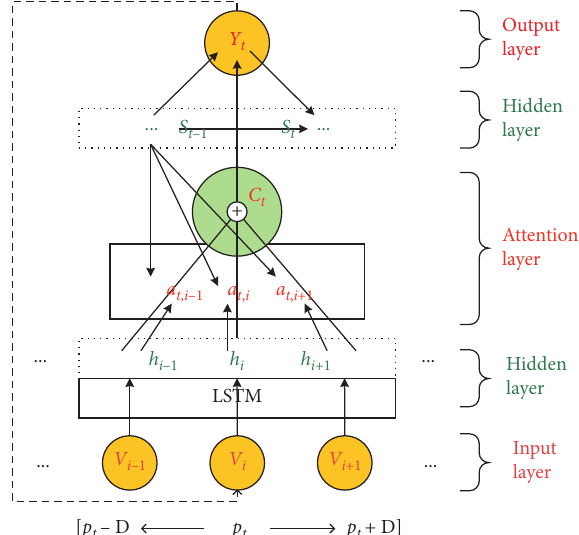
Figure 9: Attention-based LSTM model.